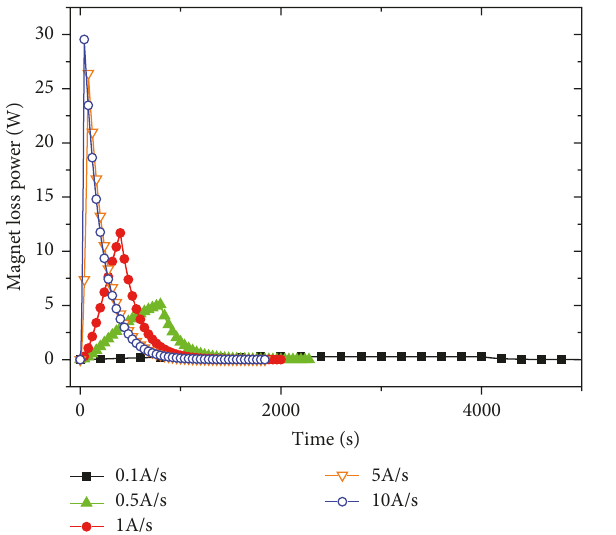
Figure 12: Loss dependence on I